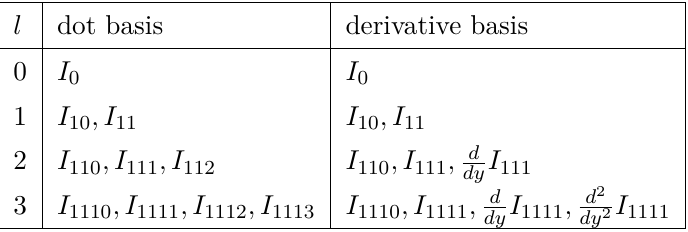
Table 1 . Possible bases of master integrals for l ∈ { 0 , 1 , 2 , 3 }